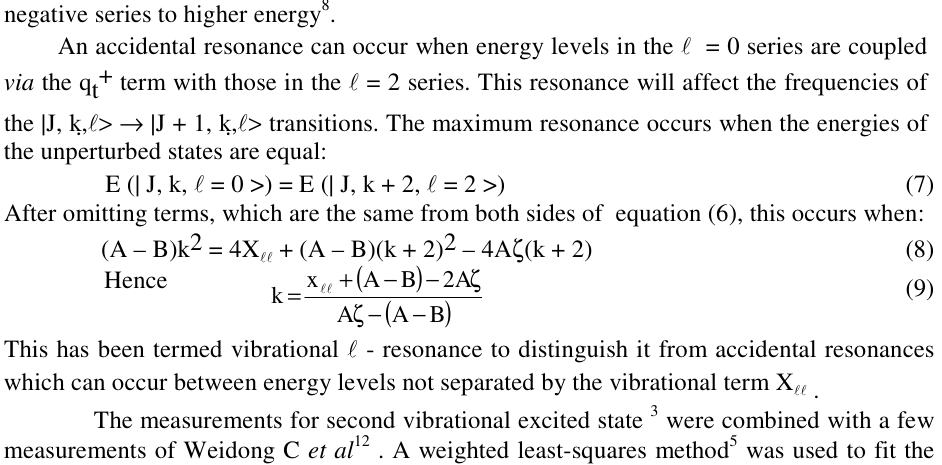
Table 3 . The Results of Refinement of Observed Frequencies for CD